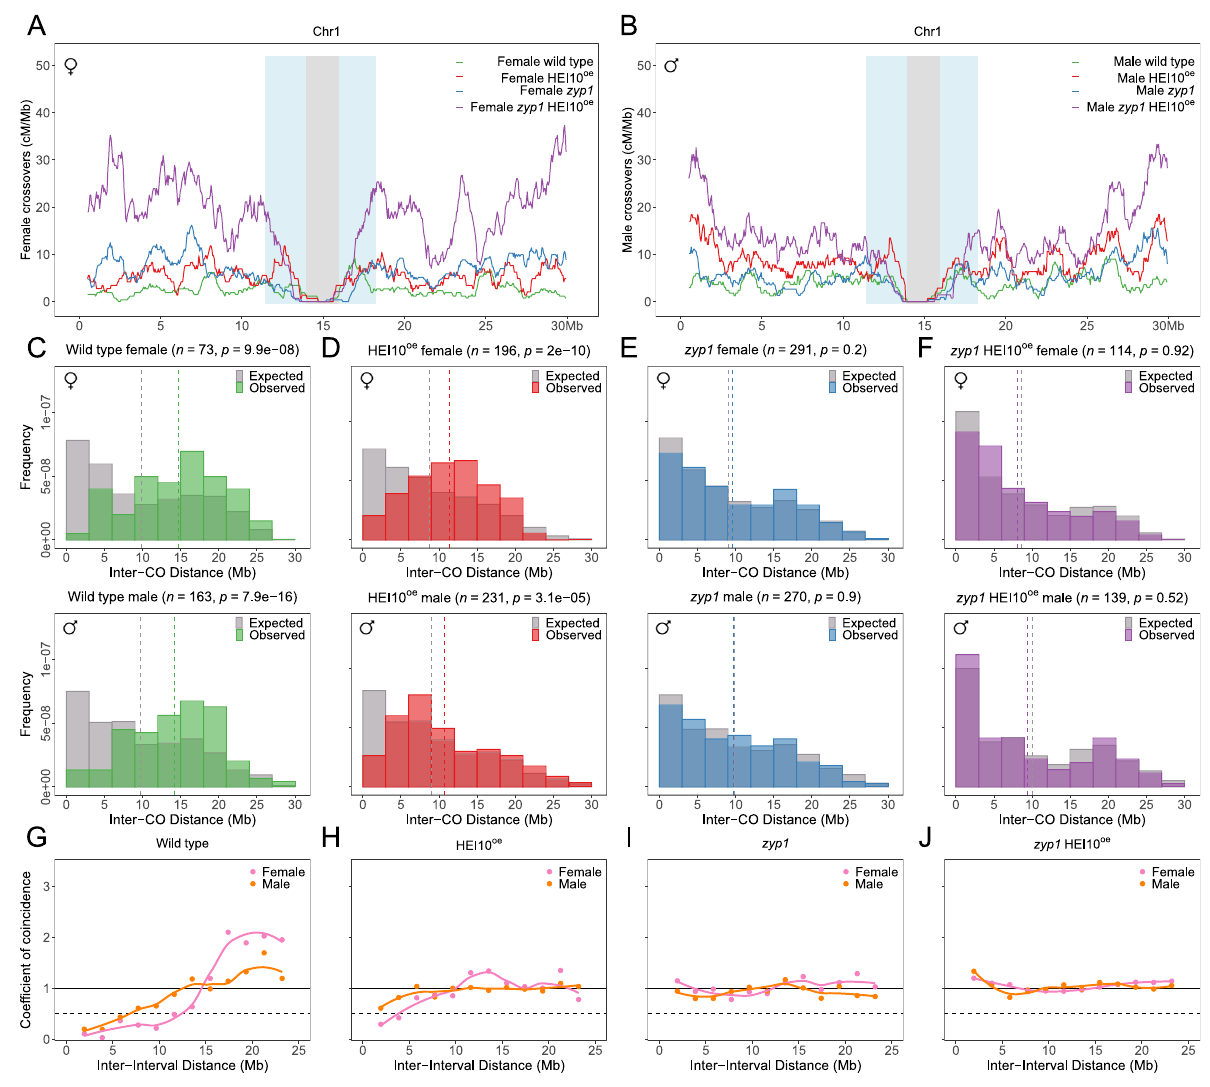
Fig. 2 | CO distribution and interference analysis in female and male wildtype, HEI10 oe , zyp1 , and zyp1 HEI10 oe . The distribution of COs on chromosome 1 in A female and B male of wild type, HEI10 oe , zyp1 , and zyp1 HEI10 oe . The